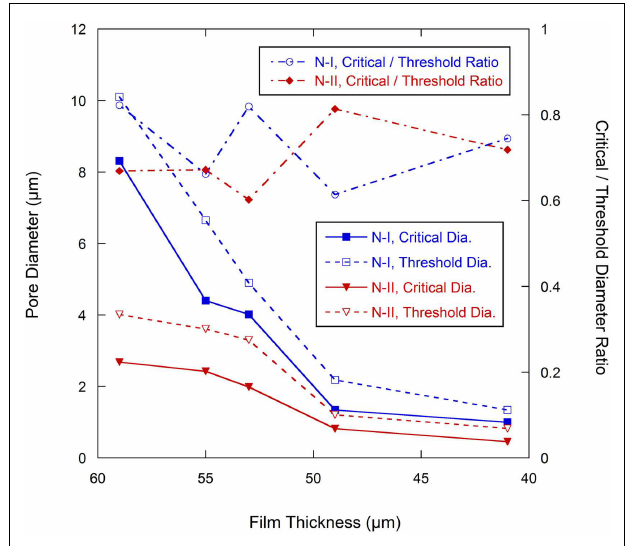
FIGURE 7 | Pore diameter change with calendering force (Primary axis), ratio of dcr/dth change with calendering forces (secondary axis) .